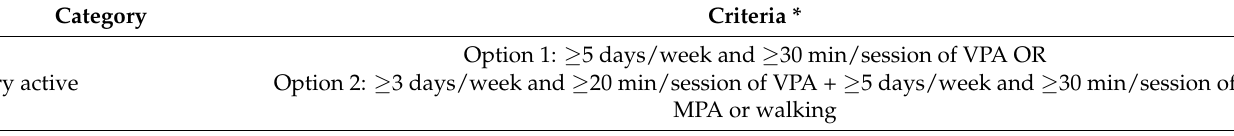
Table 1. Criteria used to categorize participants according to their self-reported physical activity [3]. Category Criteria